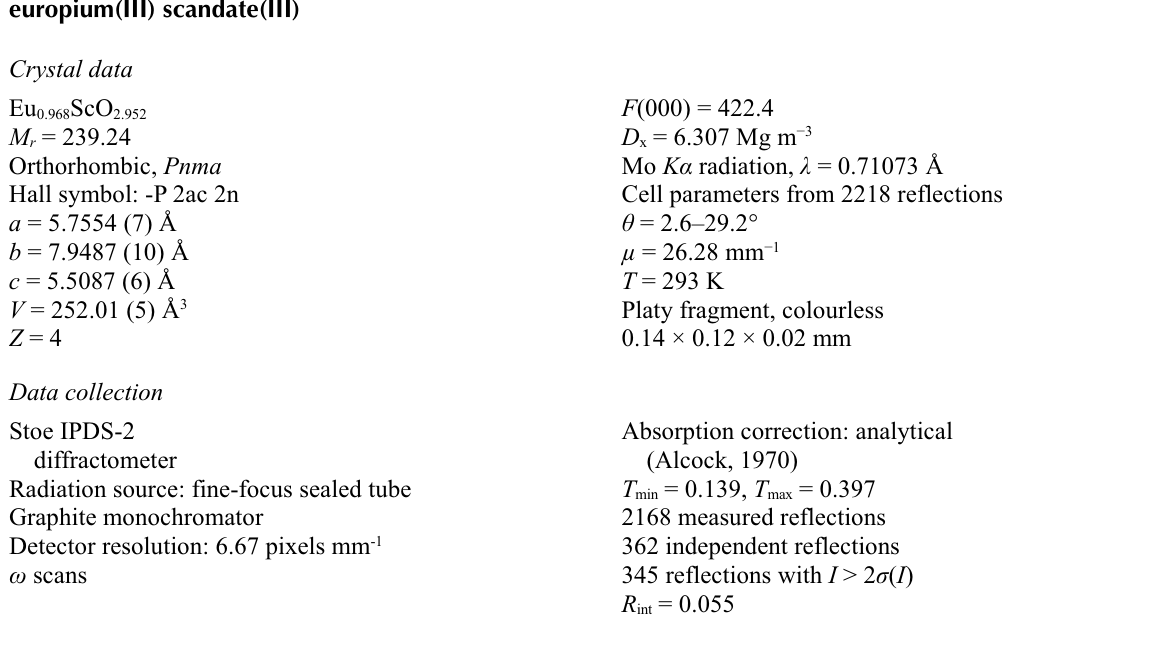
structure along [010], showing the Eu atoms and the Sc coordination with displacement Projection of the EuScO 3 ellipsoids at the 80% probability